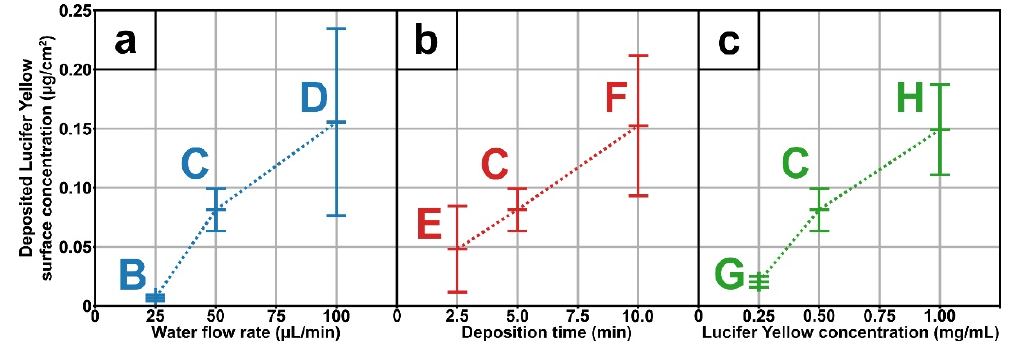
Figure 4. Quantification of Lucifer Yellow in coatings depos ited with different water flow rate ( a ): 25 µ L/min (B), 50 µ L/min (C), and 100 µ L/min (D); for different time ( b ): 2.5 min (E), 5 min (C), and 10 min (F); and for different Lucifer Yellow concentration in the water aerosol ( c ): 0.25 mg/mL (G), 0.5 mg/mL (C), and 1 mg/mL